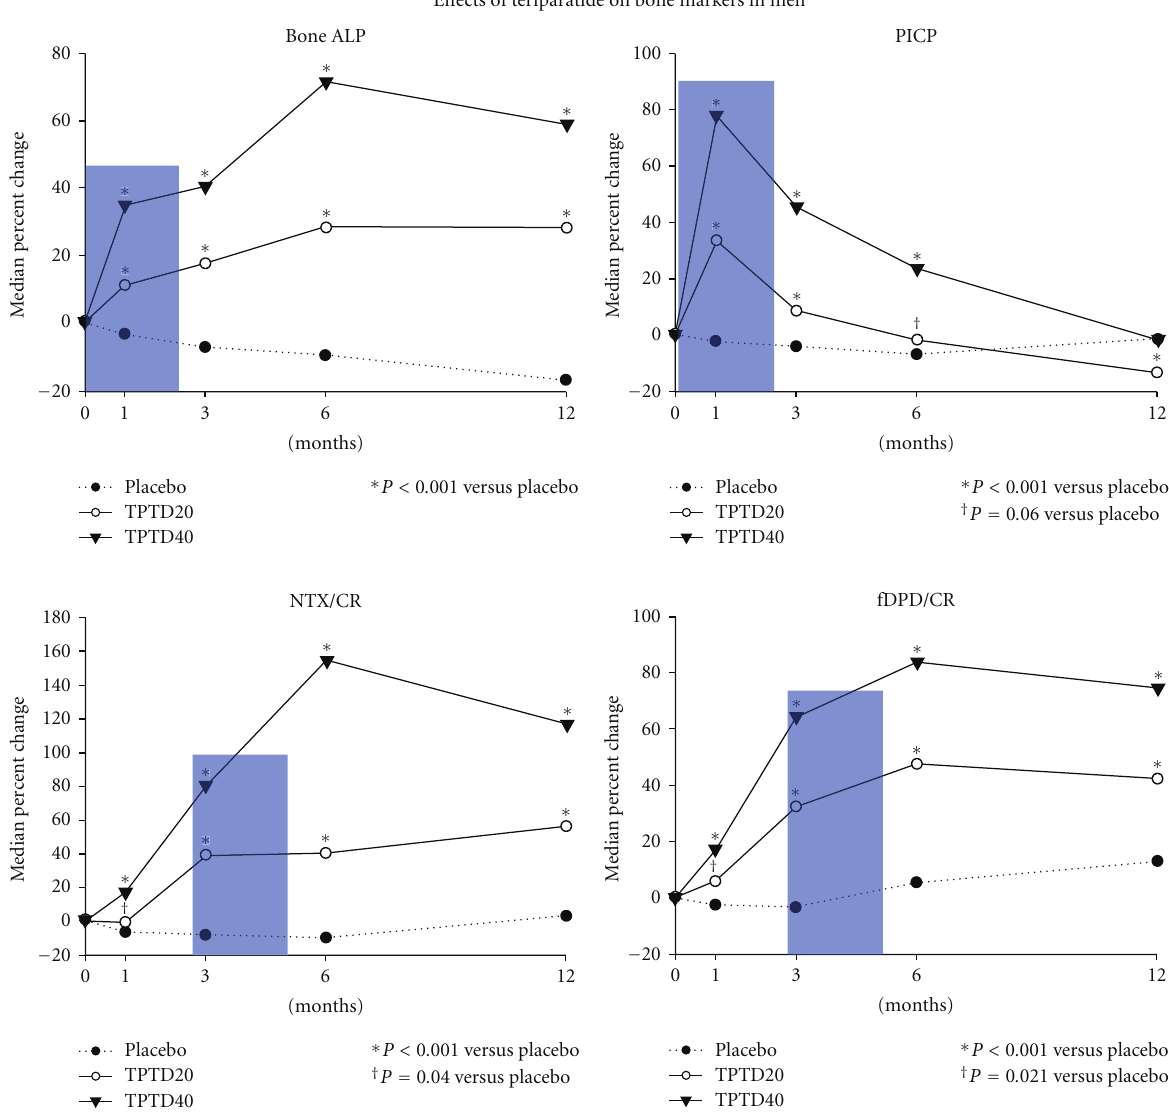
Figure 2: Changes in bone turnover markers after teriparatide administration to men with osteoporosis. Bone formation markers increase before bone resorption markers after men are exposed to teriparatide. Bone ALP, bone alkaline phosphatase; PICP, procollagen I carboxy- terminal; NTX/CR, urinary N-telopeptide/creatinine ratio; fDPD/CR, free deoxypyridinoline/creatinine ratio; TPTD20, teriparatide 20 µ g; TPTD40, teriparatide 40 µ g. From Orwoll et al.